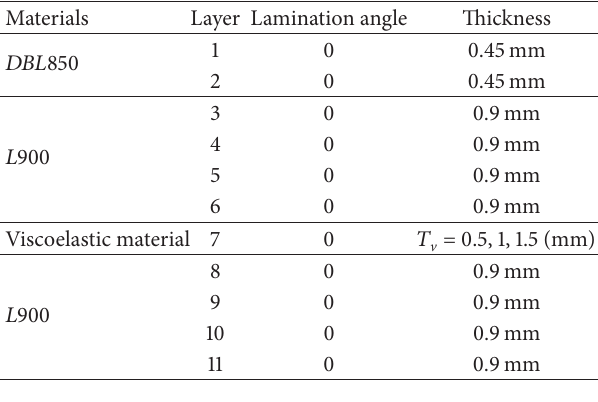
Table 2: Lamination type of clamped free shell structure and blade.